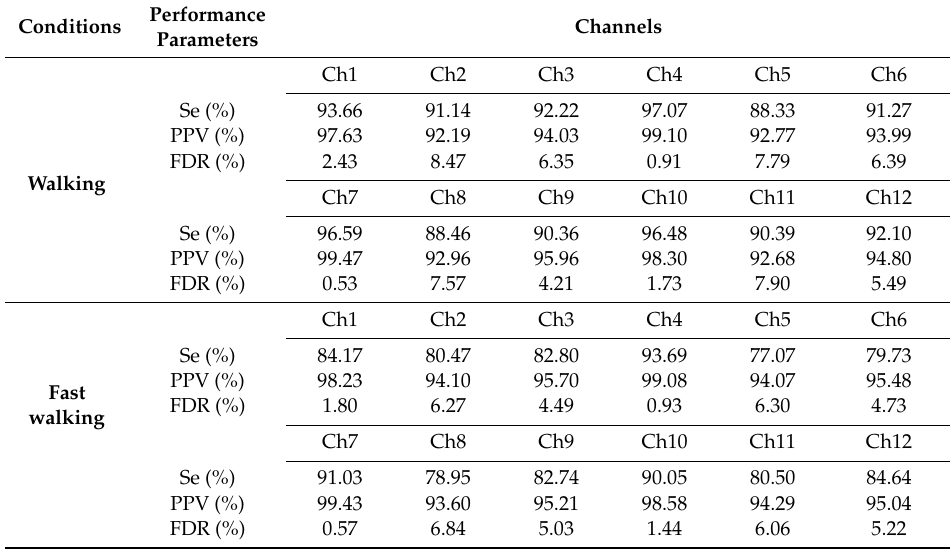
Table 1. Comparison of the results of Se, PPV, and FDR for the 12-channel signals acquired during walking, fast walking, and running